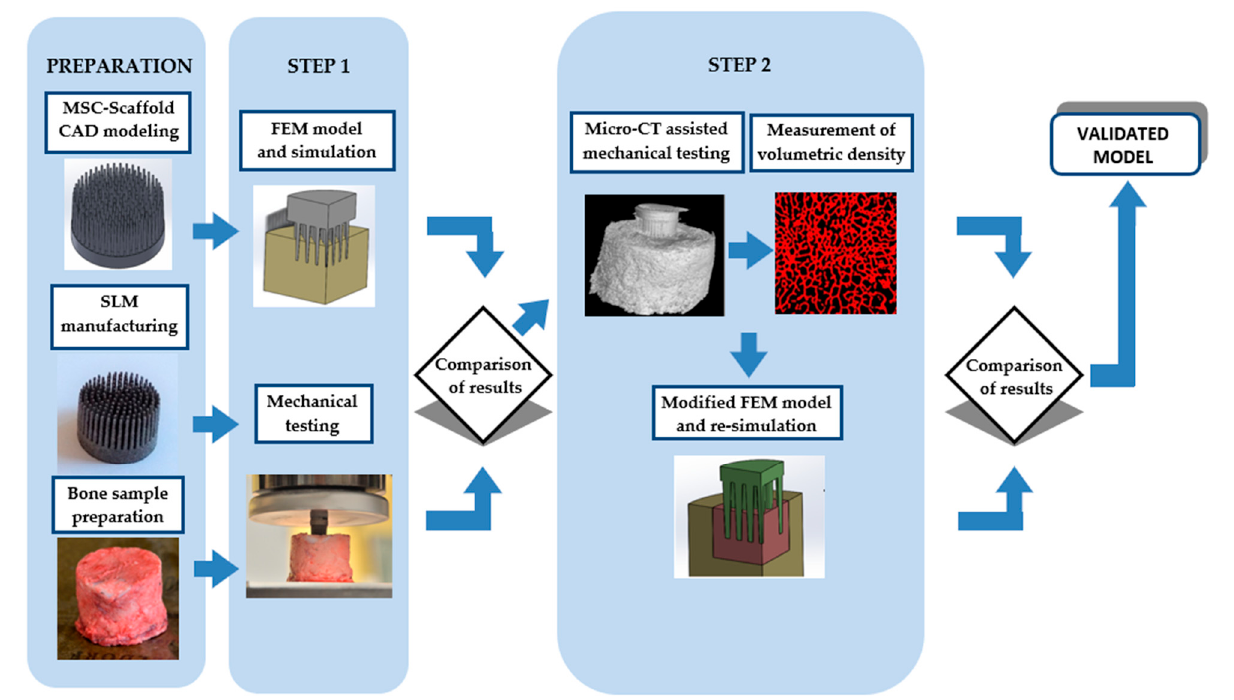
Figure 1. A schematic description of the experimental validation of the finite element (FE) model of the multi-spiked connecting scaffold (MSC-Scaffold) prototype embedded in periarticular bone.